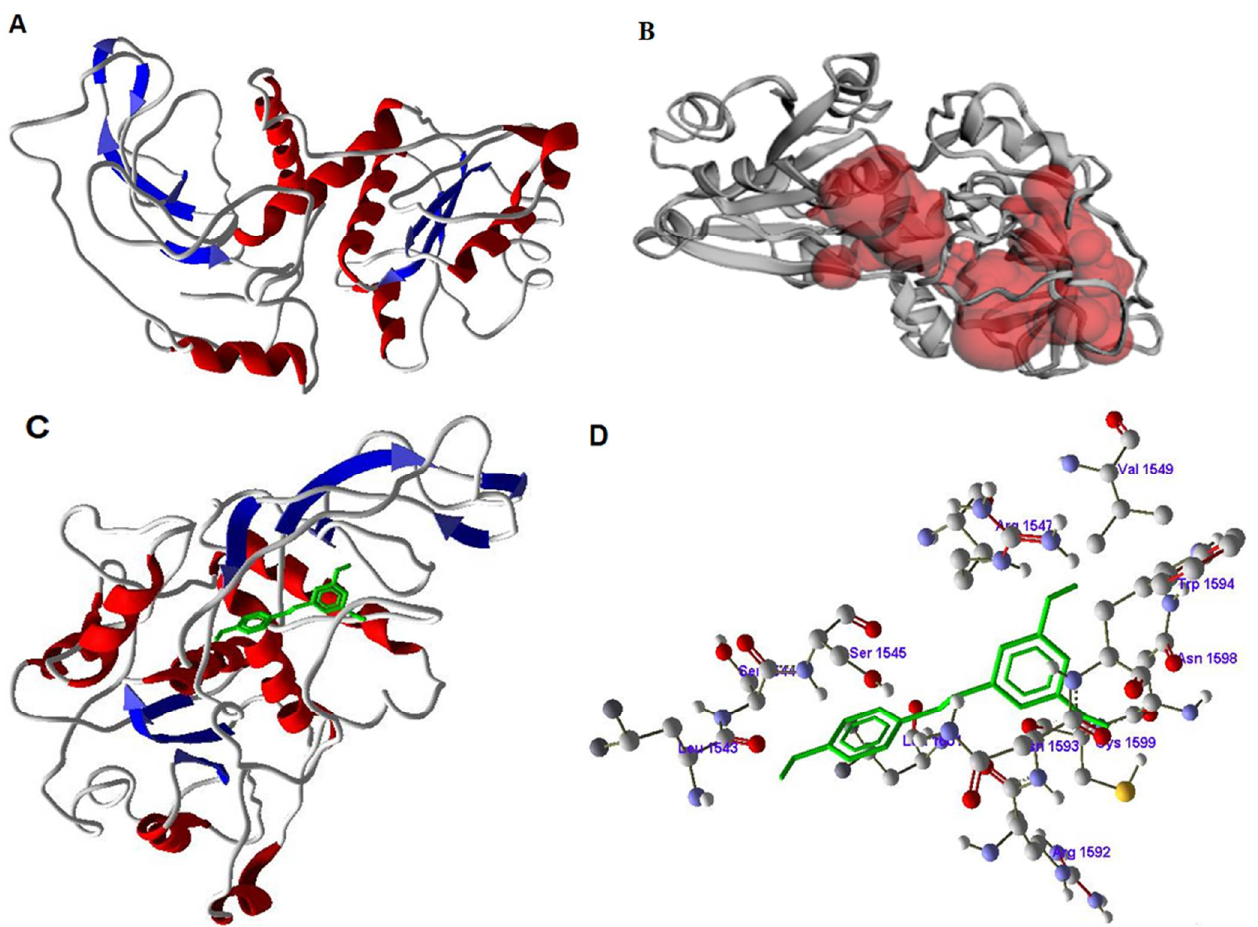
Figure 7. Inhibitory studies of resveratrol with fatty acid synthase ( FASN ). ( A ) Structure of FASN with helices (red color) and sheets (blue color), ( B ) active site of FASN in red color pocket in the structure, ( C ) docking of Resveratrol (green color) with FASN, and ( D ) amino acids of FASN involved in docking with resveratrol.